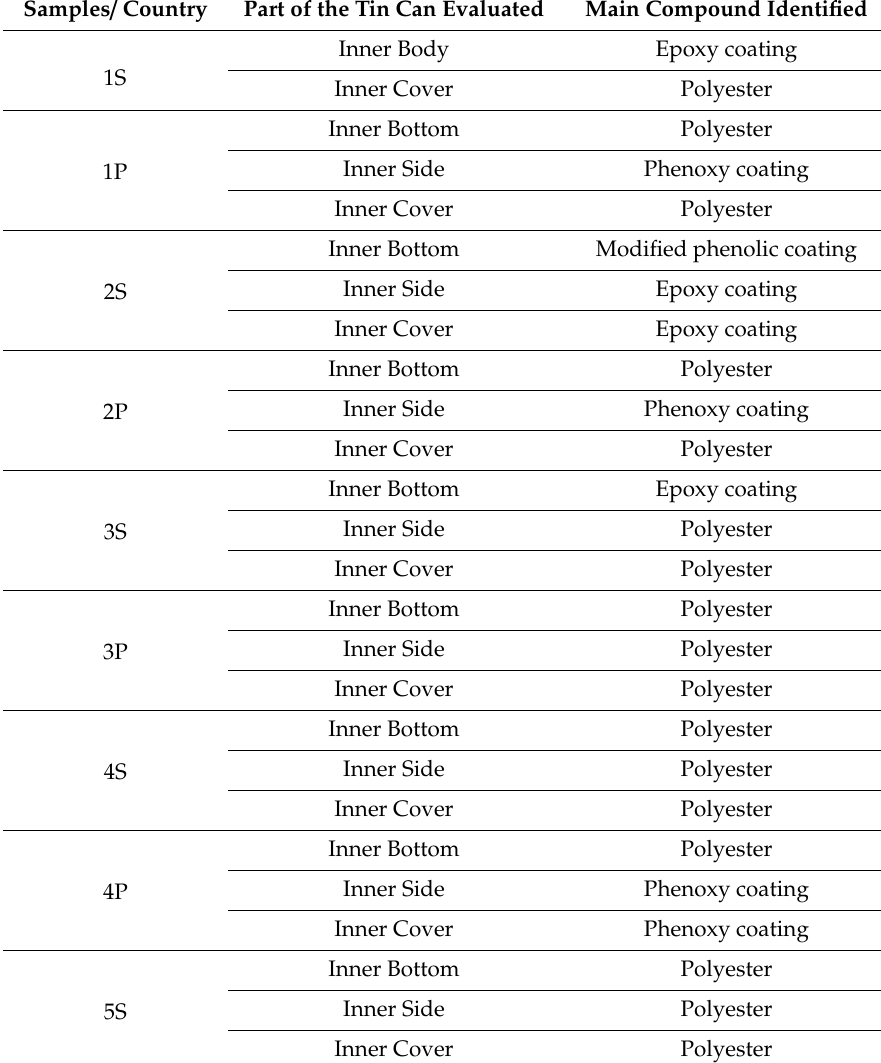
Table 6. Main compound identified for each of the samples